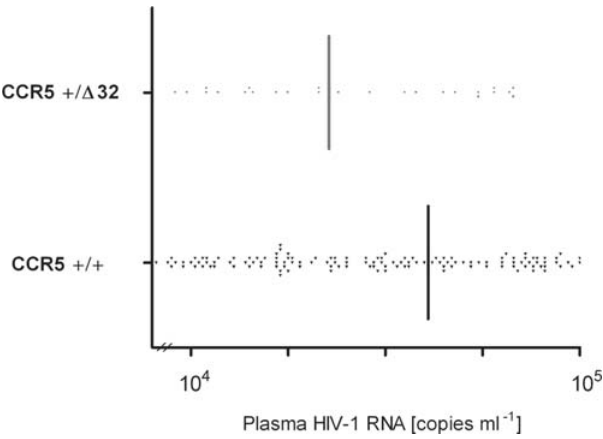
Figure 1. Relation of CCR5 D 32 genotype with viral setpoints in 319 Caucasian seroconverters. Scattered dots represent individual viral setpoints (see Material and Methods for a definition), whereas vertical lines demarcate the median in each genetic group.